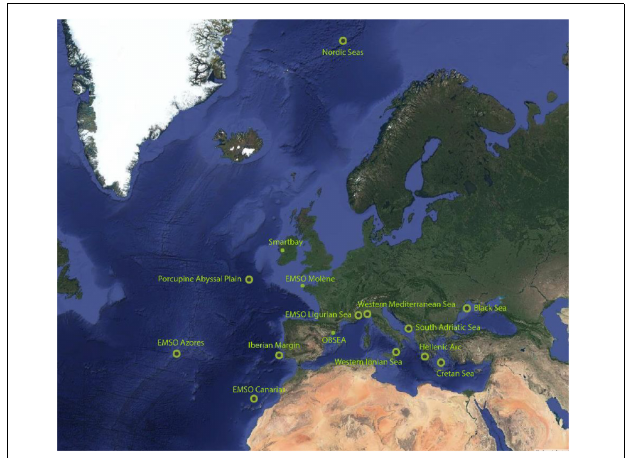
FIGURE 1 | Geographical distribution of the EMSO Regional Facilities (open green circles) and test sites (solid green